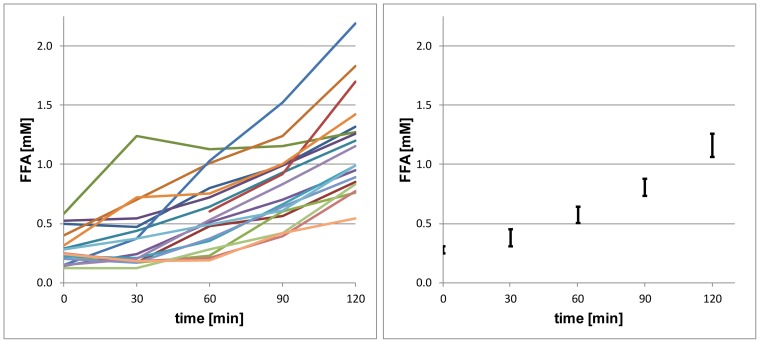
Effect of aerobic exercise on serum free fatty acid concentrations.Individual (left) and overall (mean ± 1 SEM) levels of circulating FFA during the course of the 2 h-aerobic exercise at 50% VO2max.